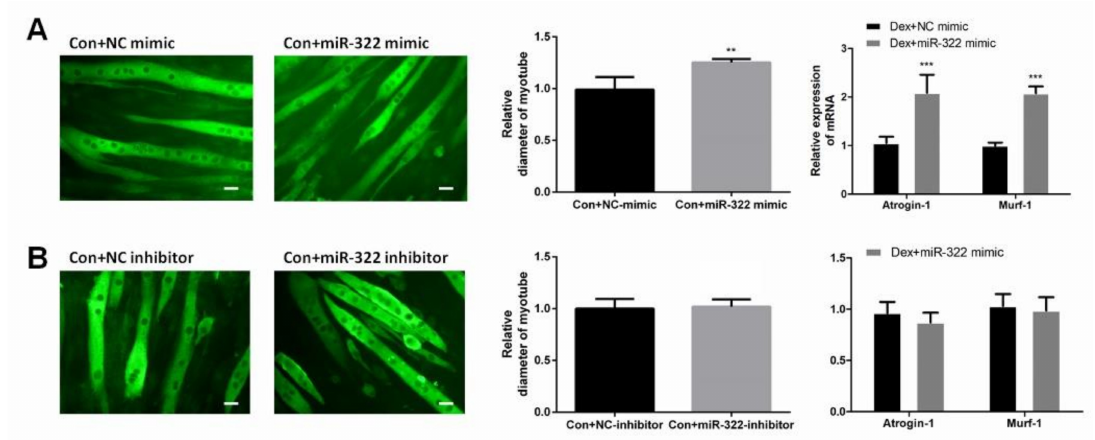
Figure 4. miR-322 induced muscle atrophy in vitro. ( A ) Immunofluorescent staining for MyHC in C2C12 myotubes showed reduced myotube diameter, accompanied with increased Atrogin-1 and MuRF-1 expression after transfection with miR-322 mimic. ( B ) Immunofluorescent staining for MyHC in C2C12 myotubes displayed no significant change in the myotube diameter and expressions of Atrogin-1 and MuRF-1 after transfection with miR-322 inhibitor. Scale bar, 10 µ m. Con, control. Dex, dexamethasone. ** p < 0.01 and *** p <